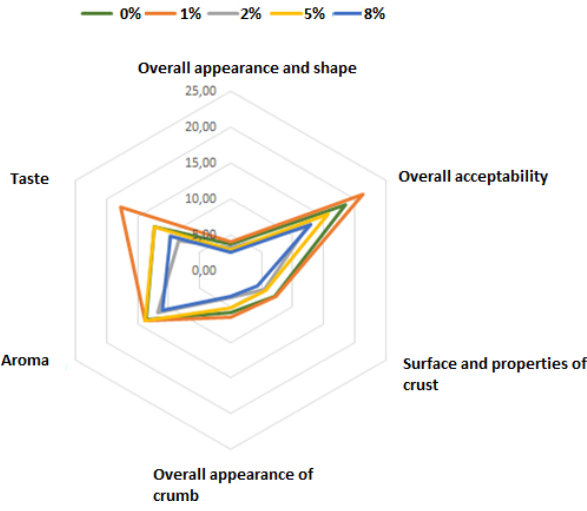
Figure 3: Radar plot obtained from sensory evaluation of bread samples with different (0%, 1 %, 2 %, 5%, 8 %) concentrations of